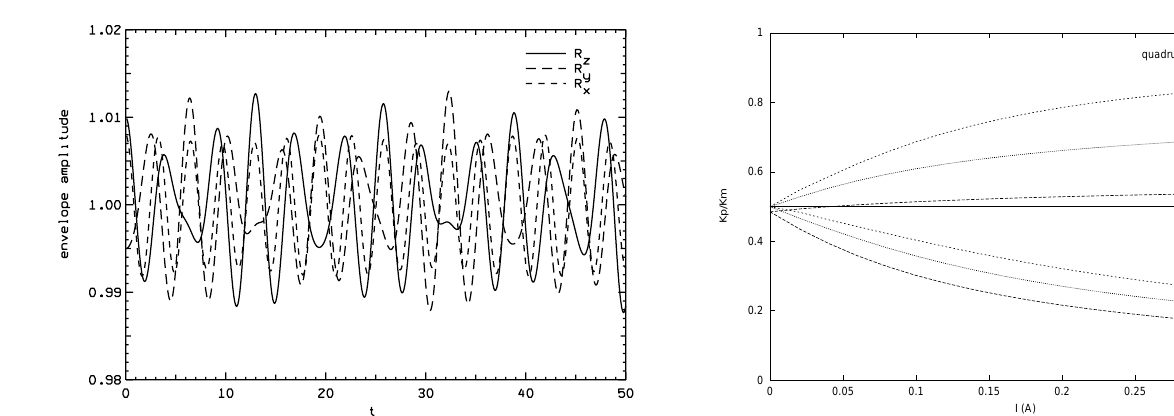
FIG. 3. The ratio of particle betatron wave number to mode wave number as a function of current.